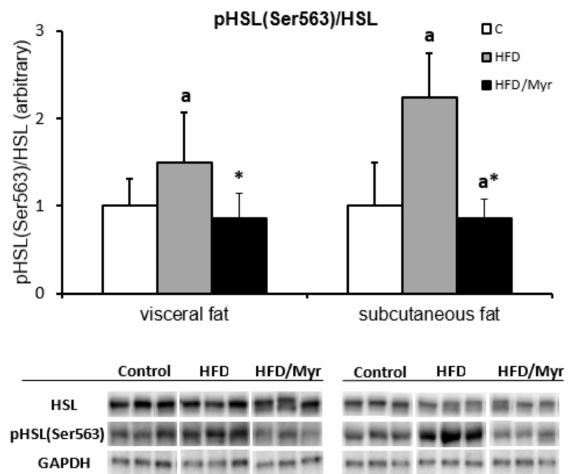
Figure 2. A ratio of pHSL (Ser563) to HSL in two depots of adipose tissue. White bars—control group; grey bars—HFD group; black bars—HFD/Met group. Values are mean +/ − SD. Symbols denote statistical significance of p < 0.05 versus: a —vs. Control group; *—vs. HFD